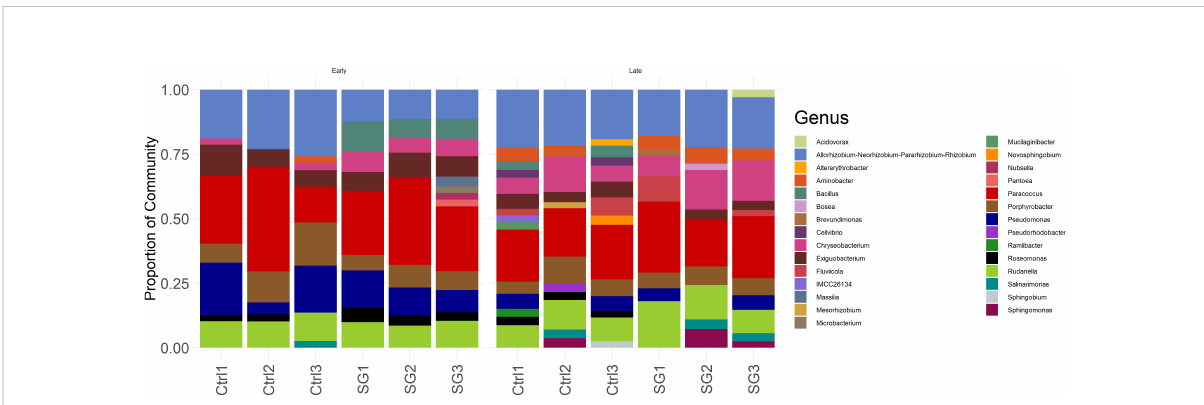
FIGURE 3 Bacterial community composition during early log phase ( “ Early ” ; Left) and late log phase growth ( “ Late ” ; Right) of S. obliquus with ( “ SG ” ) and without ( “ Ctrl ” ) raw switchgrass at 50 L scale in mini raceway ponds. Only genera with an average abundance greater than or equal to 2% were included in this fi